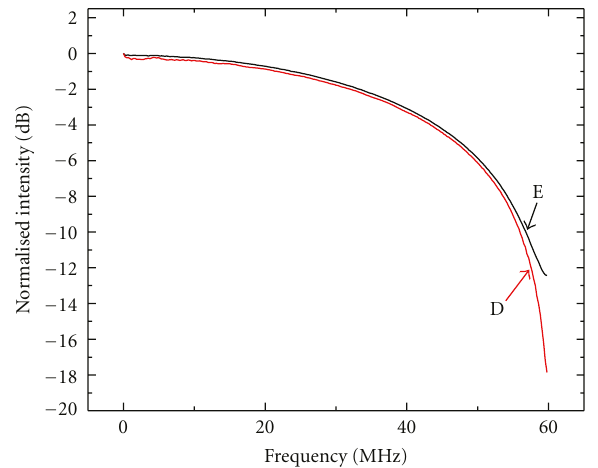
Figure 12: Frequency responses for configuration D and E as light undergoing up to five reflections.